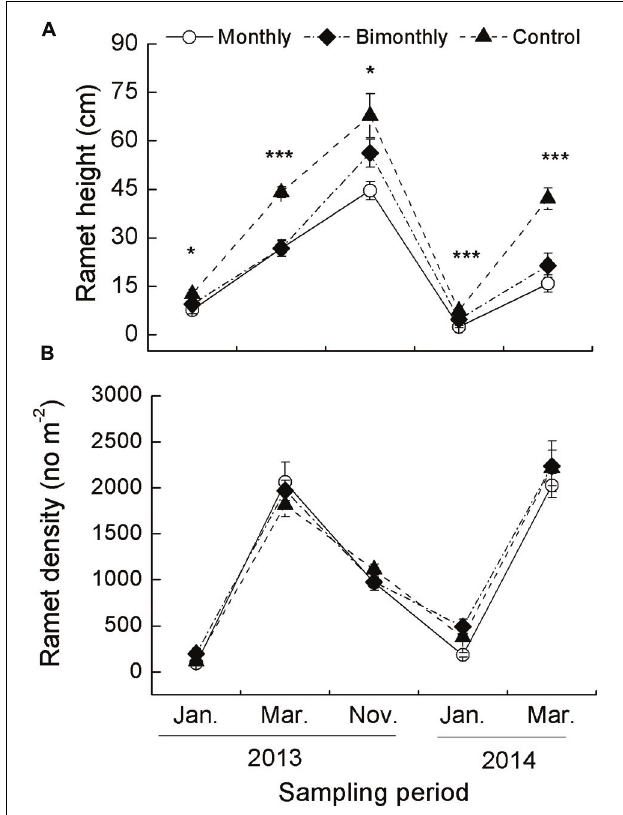
FIGURE 1 | Ramet height (A) and density (B) of Carex brevicuspis populations for three defoliation frequencies, January 2013–March 2014. The data are expressed as the mean ± standard error (SE). ∗ p < 0.05, ∗∗∗ p < 0.001.